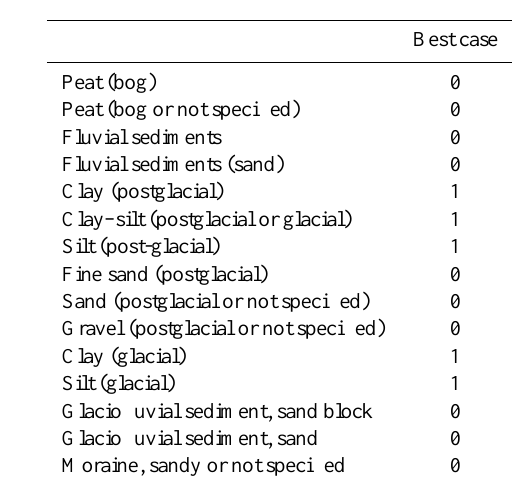
Table 2. Soil deposits considered unstable (1) in the best-case sce- nario.